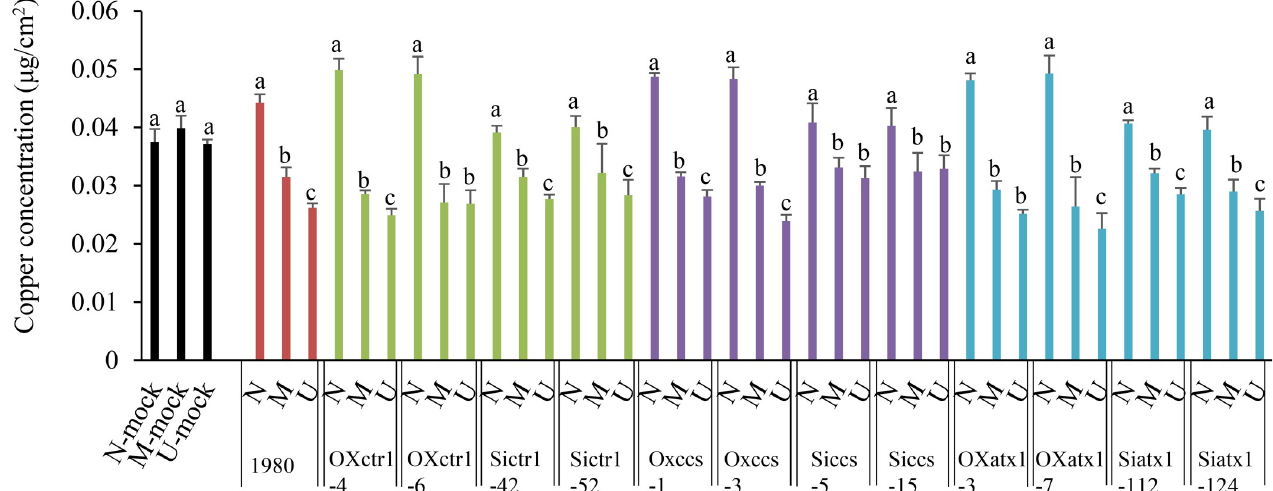
Fig 5. SsCTR1 , SsCCS and SsATX1 associates with copper absorption during infection. Copper concentration in uninfected (U), margin (M) and necrotic (N) tissues of B . napus cv. Zhongshuang11 leaves at 48 hpi with wild-type strain 1980, silenced and overexpression strains. Error bars indicate the standard deviation of three independent replicates with six leaves for every sample in one replicate. Different letters indicate statistically significant differences ( P < 0.05, Student’s t -test).